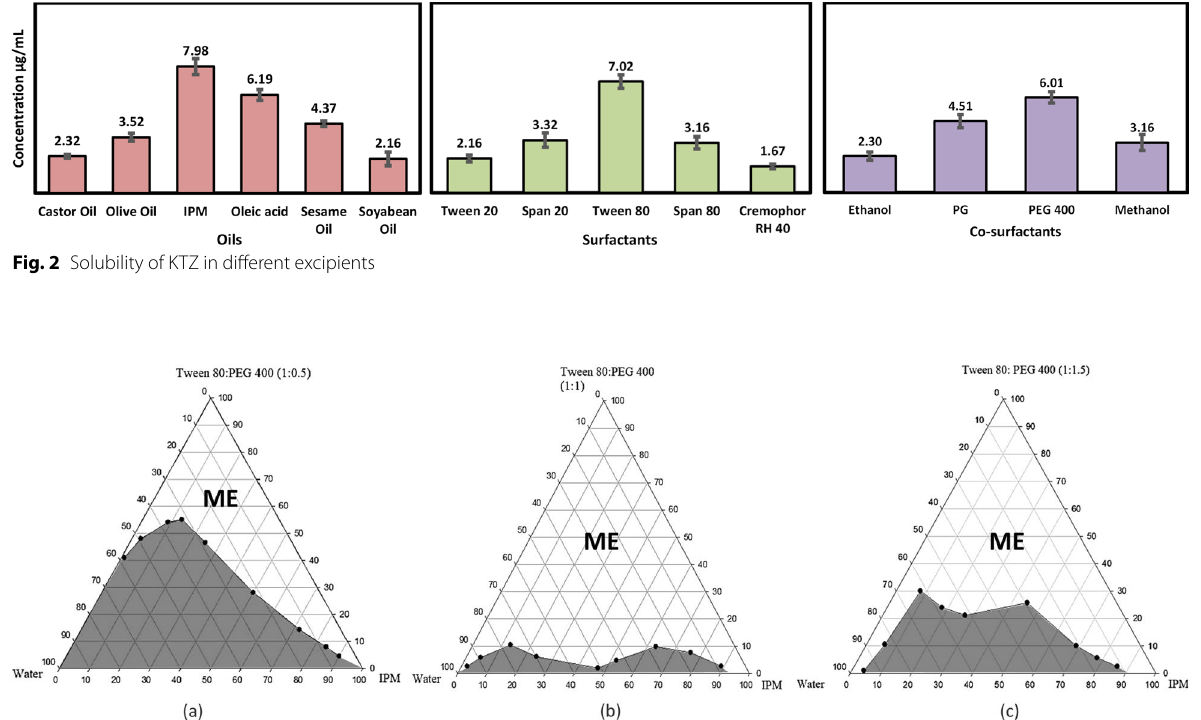
Fig. 3 Pseudo-ternary phase diagrams of SEDDs where Tween 80 and PEG 400 were used in the ratio: a 1:0.5, b 1:1, and c 1:1.5. The non-shaded region in the ternary phase diagram indicates the microemulsion region represented by